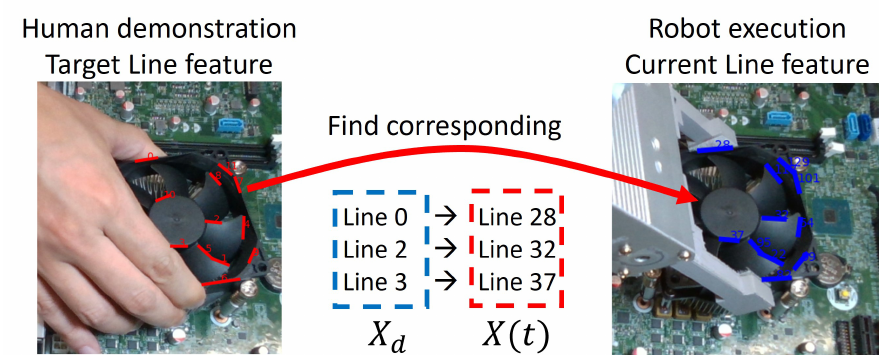
Figure 6. Line matching between the target image and current image for visual servoing.